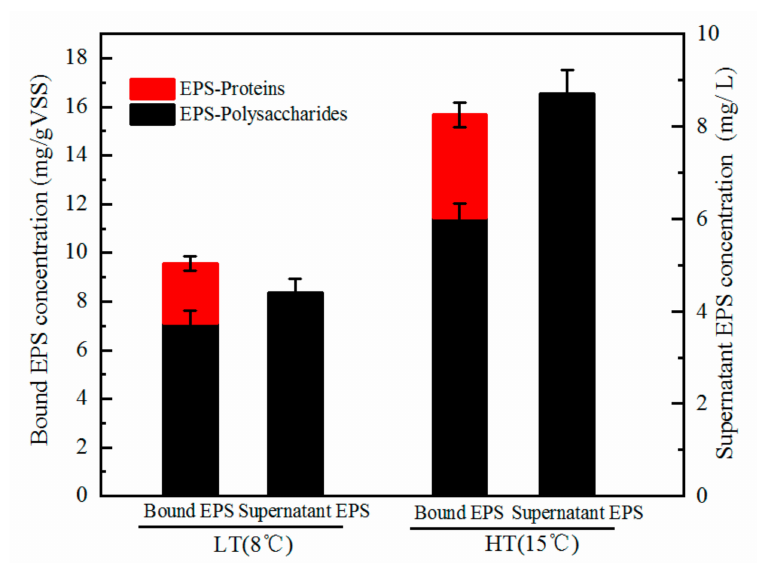
Figure 5. Bound EPS (extracellular polymeric substance), free EPS, EPS-protein, and EPS-polysaccharide concentrations in the concentrate and the supernatant at di ff erent temperatures. Table 2. Na, Ca, and Al concentration in the supernatant and concentrate of the HLB-MRs. Supernatant Concentration (mg /